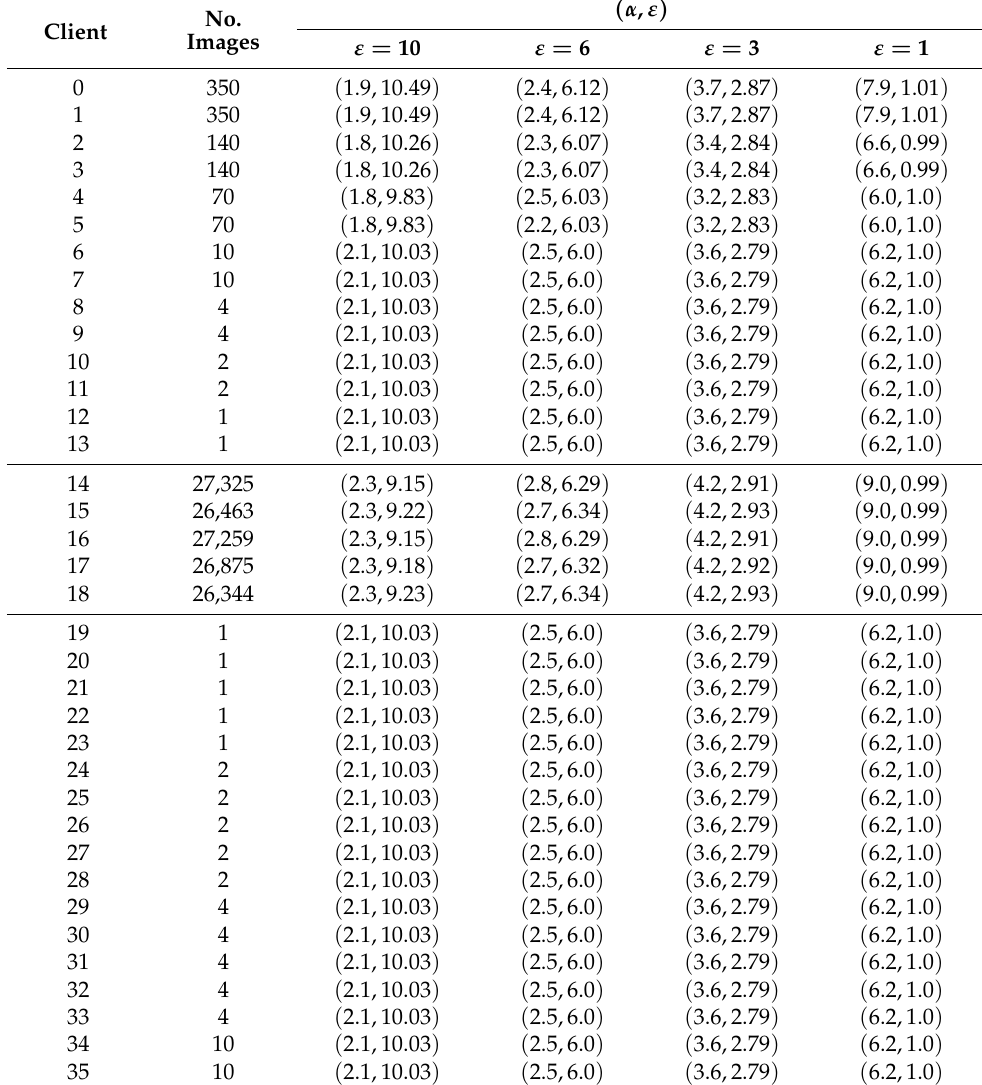
Table A1. Optimal ( α , ε ) -pairs under fixed privacy budgets for each client’s local model of our private training baseline. True ε values may deviate slightly from the defined privacy budget as the noise multiplier is estimated before model training in order to meet the privacy constraint. Clients 0 to 13 hold Mendeley data subsets, clients 14 to 18 the CheXpert training data, and clients 19 to 35 parts of the CheXpert validation